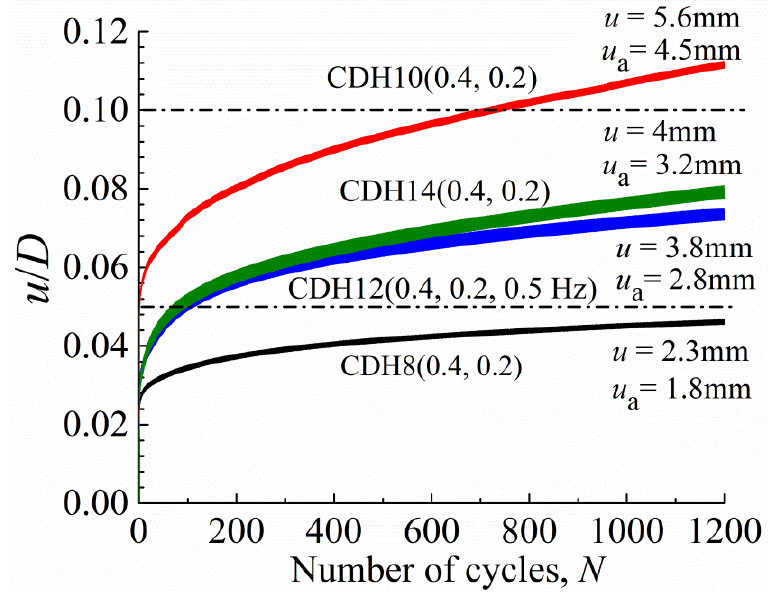
Figure 6. Developments of uplift displacement at different embedment ratios.